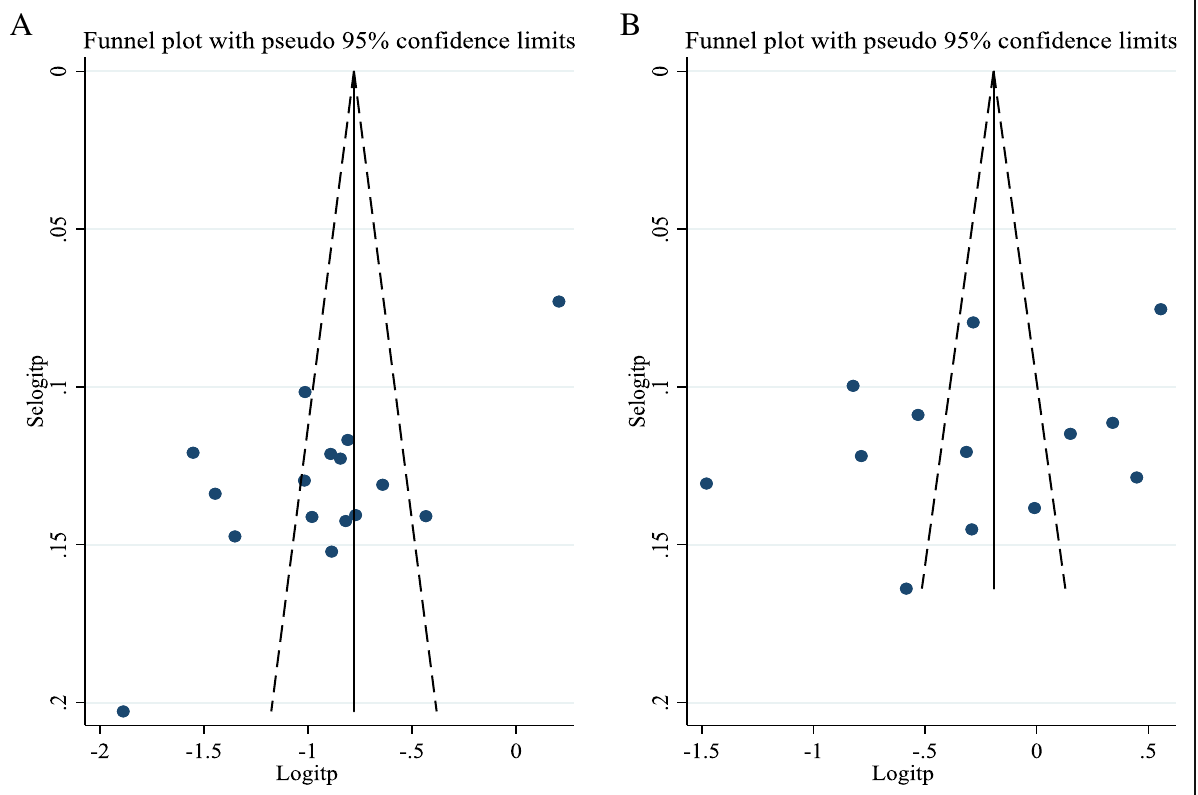
Fig. 4 Funnel plots of the 12-month ( a ) and lifetime prevalence estimates ( b ) of the needlestick injury among the Ethiopian healthcare